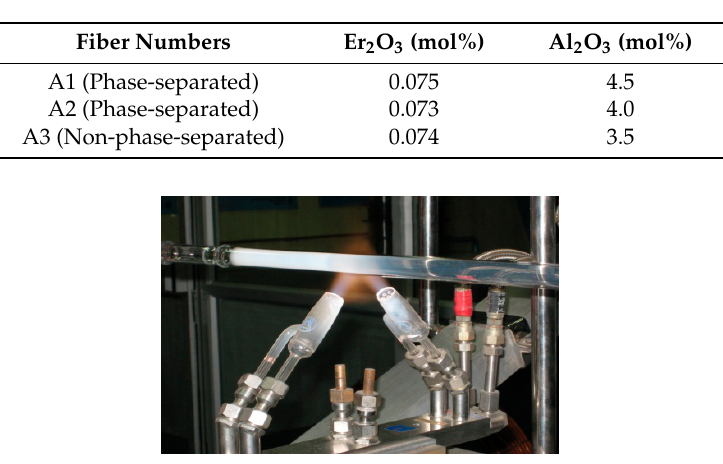
Figure 2. Modified chemical vapor deposition (MCVD) of porous silica layer within the silica tube and along the forward direction. Table 1. The composition of three Er 2 O 3 -doped fiber preforms (Measured by electron probe microanalysis).